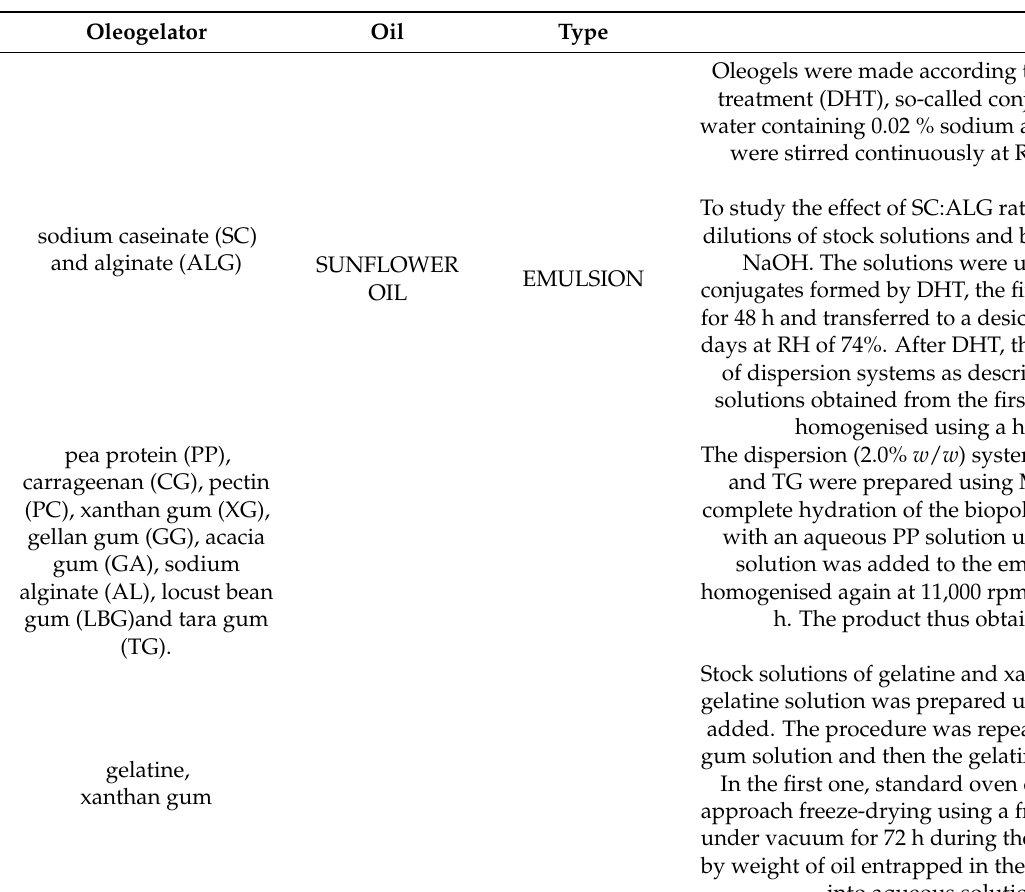
Table 1. The process conditions for manufacturing of natural gum based